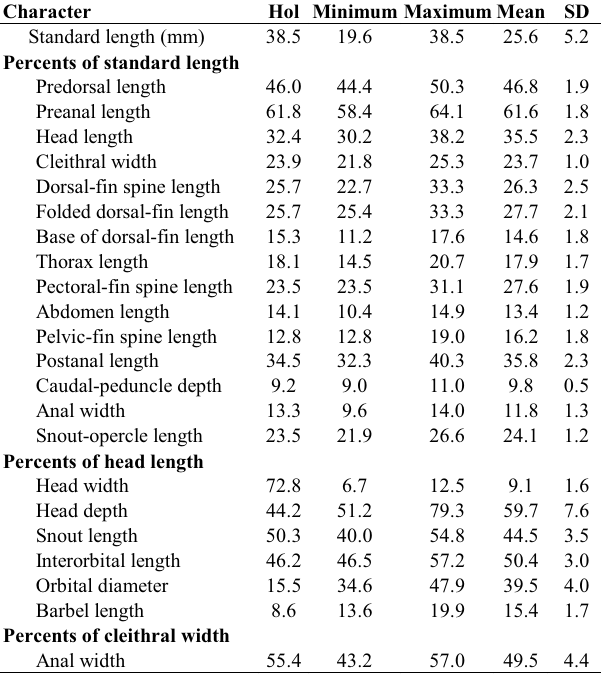
Table 1 . Descriptive morphometrics of Otothyropsis mara- poama . Values are given for the holotype (separately) and 14 paratypes. Hol = Holotype; SD = Standard